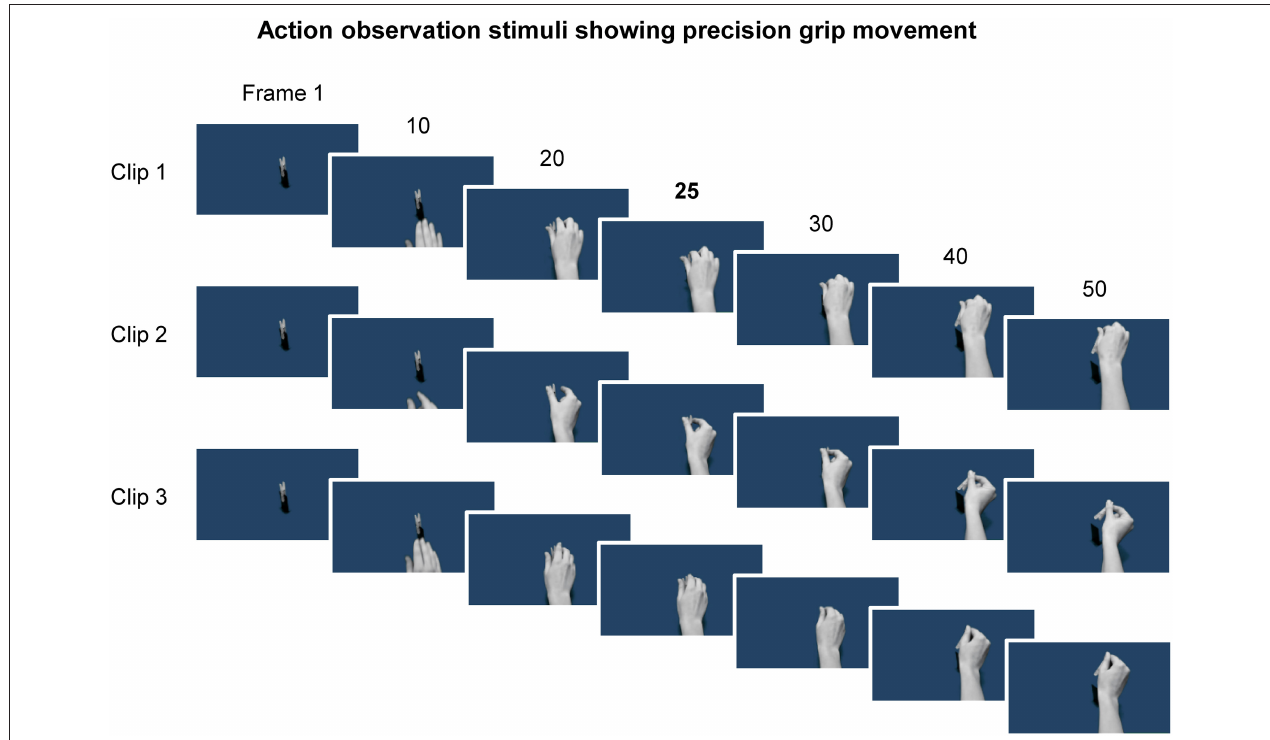
FIGURE 1 | Example frames from the three video clips showing a hand reaching and using a precision grip to pick up a peg. Representative frames from the first half of each clip, which consisted of 100 frames in total, are shown. The 25th frame is shown as this frame reflected the timing of contact between the hand and